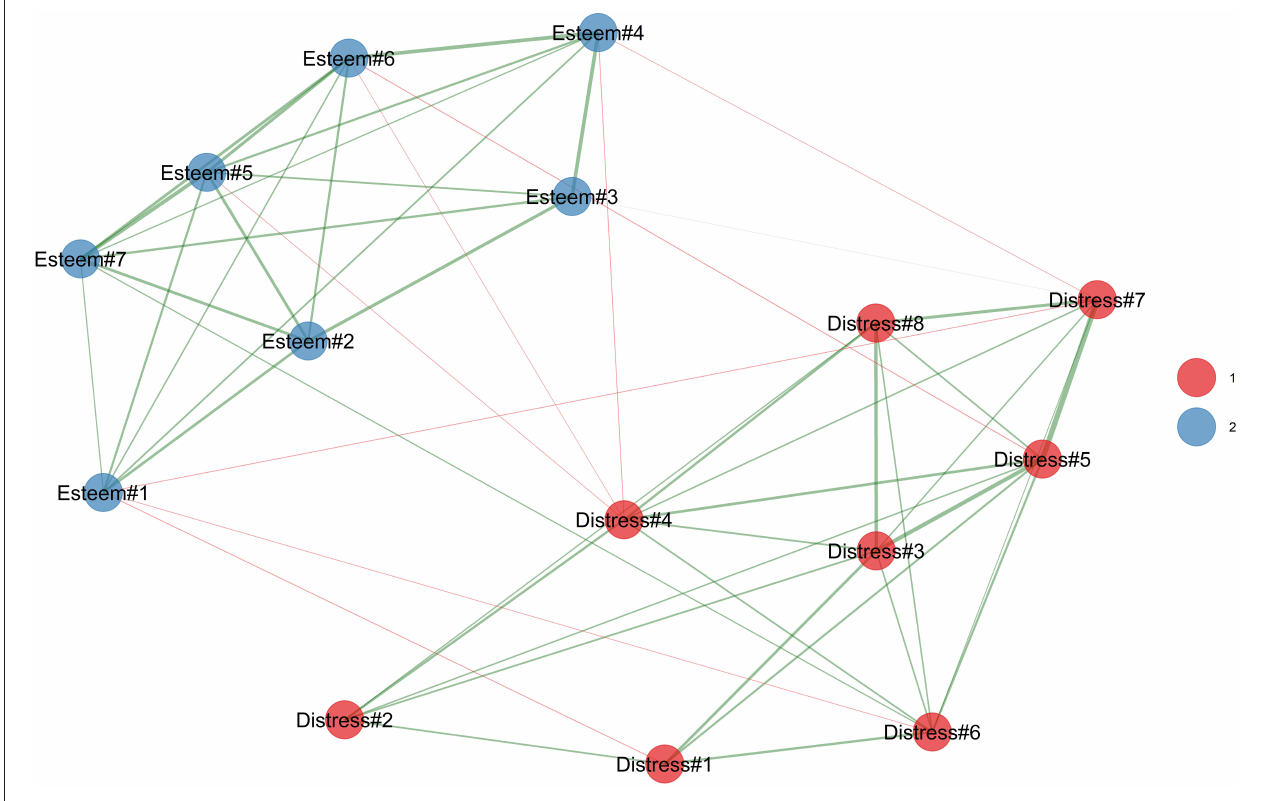
FIGURE 1 | Study 1. Exploratory graph analysis of the